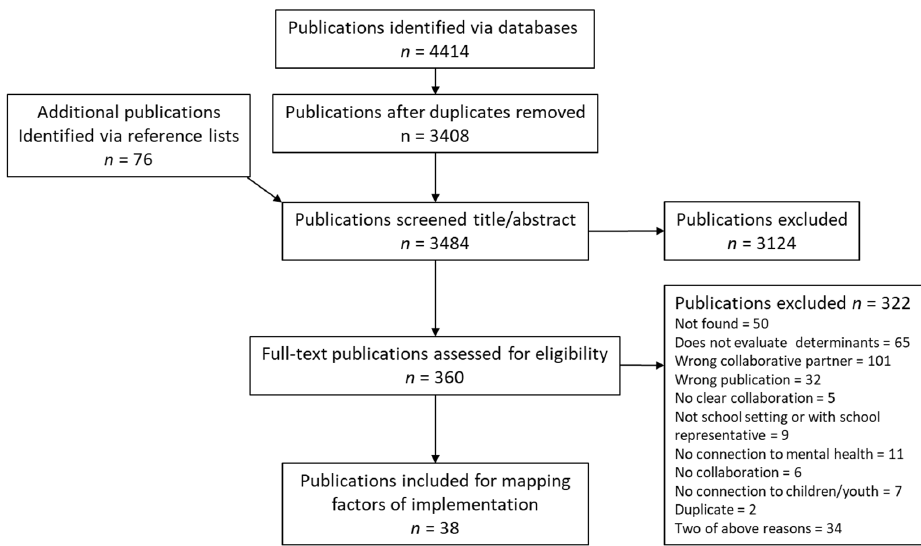
Figure 1. PRISMA flowchart for this review. Note: Eligibility criteria are presented in Appendix B. Table 1. Information about the